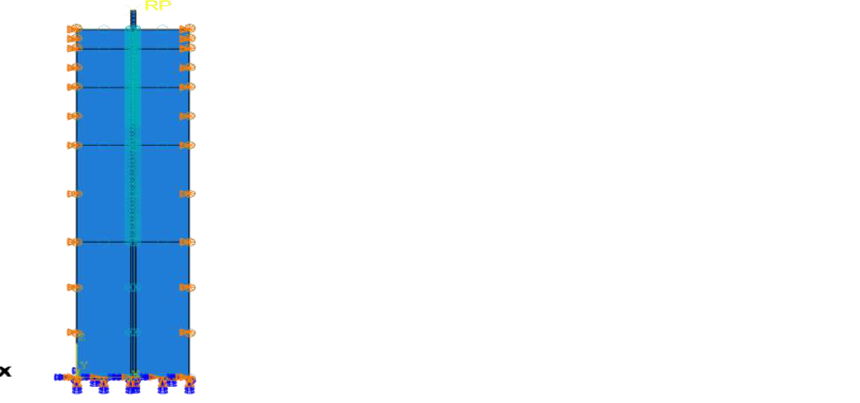
Figure 6. The 3-D FE model after completion of loading. Figure 7. The 3-D FE model after completion of meshing. 3.1.2. Simulation Results The contact surface model and Goodman contact element model are used to study the dynamic bearing capacity of the conductor. The dynamic bending moment on the top of the conductor is 𝑀 𝑡 = 3000 𝑠𝑖𝑛 𝜋 5 (𝑡 − 0.2) (kN ∙ m) , and the vertical force is 2000 kN . When 𝑡 = 22.7 s , the lateral deformation and von Mises stress obtained by the two models are shown in Figures 8 – 10, respectively. As shown in Figures 8 and 9, the lateral deformation decreases sharply along the axial direction of the conductor. In this case, the maximum lateral deformation of the con- ductor calculated by the contact surface model and the Goodman contact element model is 6.593 × 10 −2 m and 6.977 × 10 −2 m . For specific nodes, the lateral deformation calcu- lated by the Goodman contact element is greater than that calculated by the contact sur- face model. The force on the wellhead and the lateral deformation on the top of the